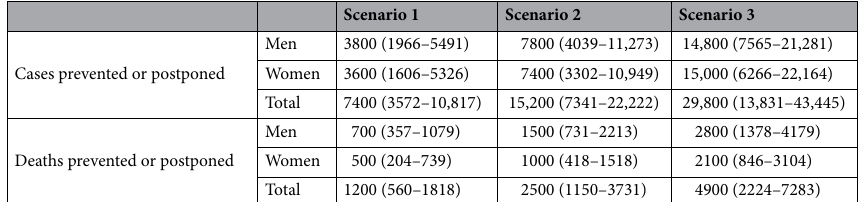
Table 4. Estimates of non-communicable diseases attributable to changes in the prevalence of overweight in three counterfactual scenarios over a 10-year simulation period, from 2021 to 2030, for Brazilian adults aged 20–79 years. Brackets contain 95% uncertainty intervals.